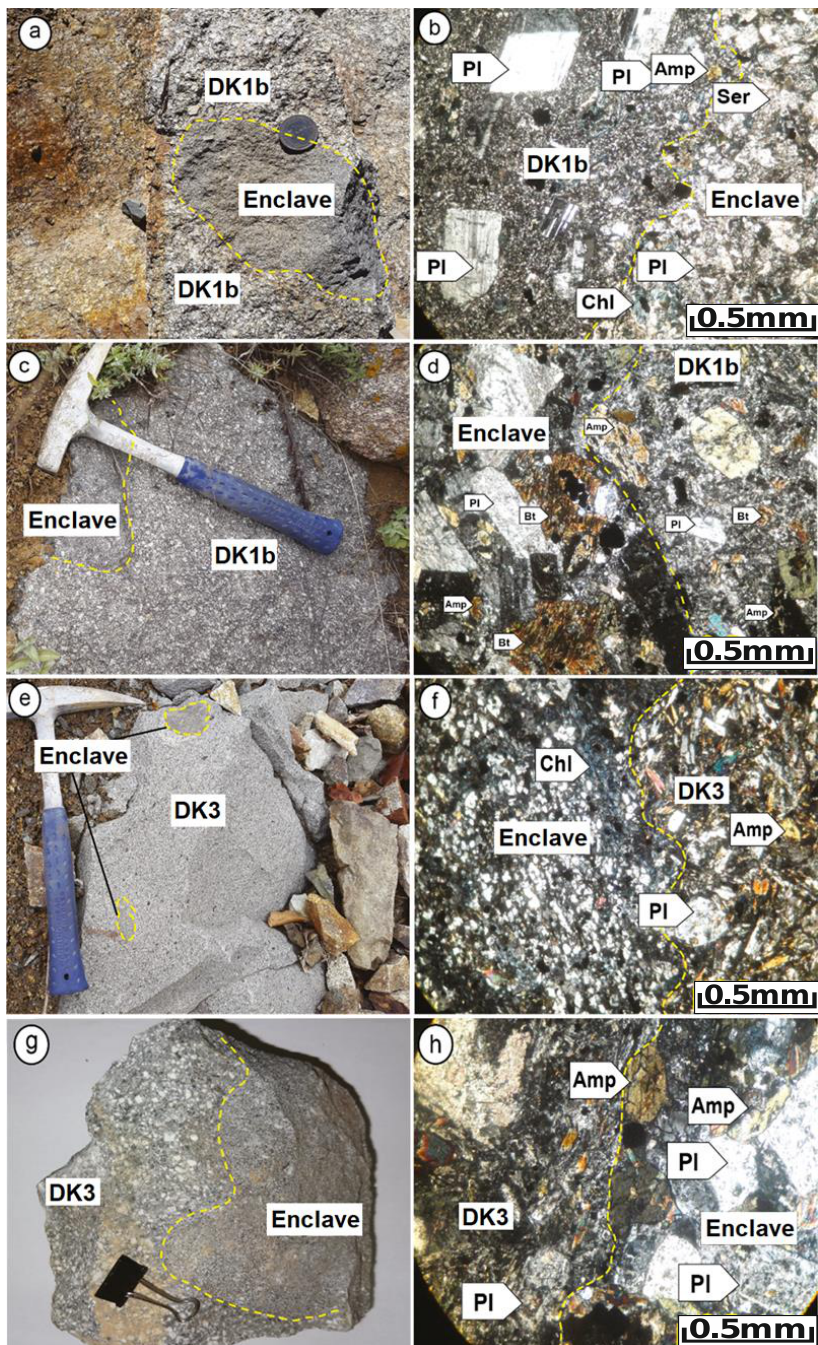
Figure 3. Hand sample (left) and thin section (right) photographs of representative samples from Sungun post-mineralization dykes. All photomicrographs are in plane polarized light. ( a , b ) Micro- diorite enclaves in DK1b dykes: ( a ) Mingled contact between a fine-grained microdiorite sheet and a medium-grained quartz diorite. ( b ) Photomicrograph showing the contact between the microdio- rite and a quartz diorite. ( c,d ) Quartz diorite enclaves: ( c ) irregular mingled contact between a fine- grained autolith and a medium-grained quartz diorite. ( d ) Boundary between the quartz diorite and its enclave. ( e,f ) Hornfels enclaves in DK3 dykes: ( e ) hornfels xenolith within an outcrop of fine- grained diorite. ( f ) Photomicrograph showing the boundary between the dyke and enclave of horn- fels in microscopic scale. ( g,h ) Diorite enclaves in DK3 dykes: ( g ) DK3 xenolith in the dioritic dykes. ( h ) Photomicrograph of the contact of DK3 xenolith with the host diorite dyke.